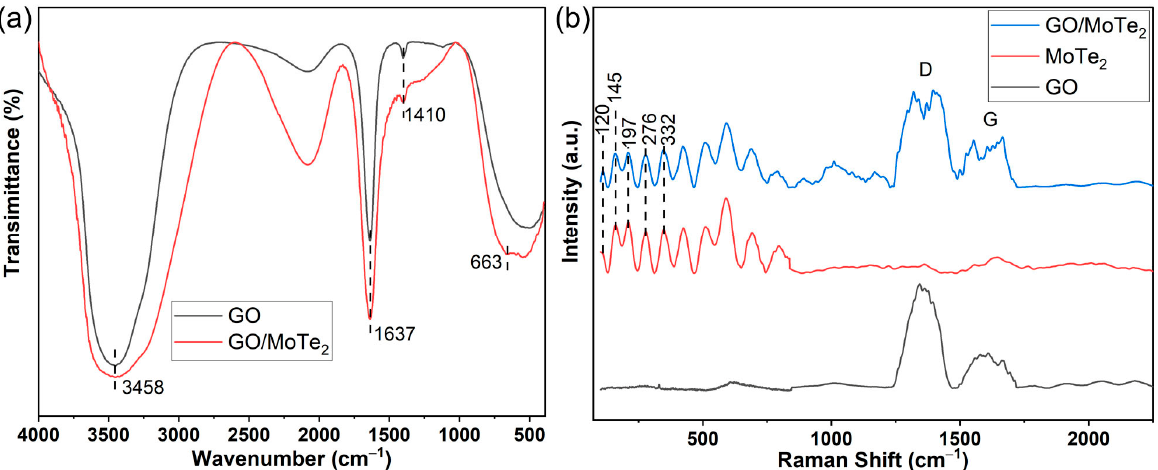
Figure 2. ( a ) FTIR spectra of GO and MoTe 2 /GO nano-hybrid; ( b ) Raman spectra of MoTe 2 , GO, and MoTe 2 /GO nano-hybrid.